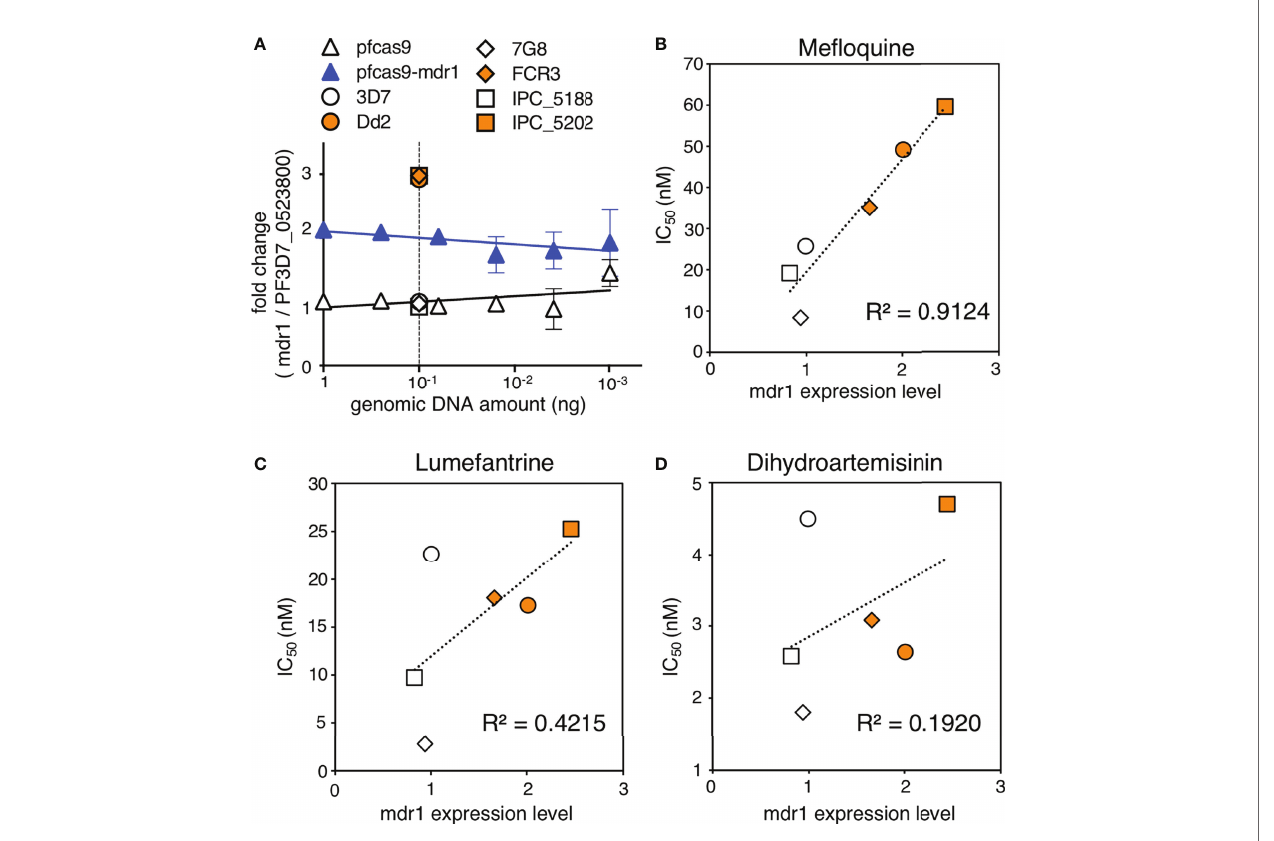
FIGURE 5 | Association of mdr1 copy number and antimalarial drug sensitivity in laboratory strains. (A) The mdr1 copy number of laboratory strains and transgenic parasites were detected by real-time genomic PCR. Dd2 and FCR3 were used as mdr1 multicopy reference parasites, and 3D7 and 7G8 were used as mdr1 single-copy reference parasites. Cambodian fi eld isolates IPC_5188 and IPC_5202 were found to have single and multiple copies, respectively. N, n = 3 – 4 ( Supplementary Table 3 ). (B – D) The laboratory strains were assayed for mdr1 expression levels and IC 50 values for me fl oquine (B) , lumefantrine (C) , and dihydroartemisinin (D) . N, n = 3 – 9 ( Supplementary Table 3 ). There was a linear correlation between the mdr1 expression levels and me fl oquine resistance (R 2 = 0.91). The association between mdr1 expression levels and lumefantrine or dihydroartemisinin resistance was unclear (R 2 = 0.42, 0.19, respectively). Data are shown as mean ± SD. The coef fi cient of determination, R 2 , was de fi ned using linear regression modeling. The strains with multiple copied mdr1 are indicated with orange- fi lled